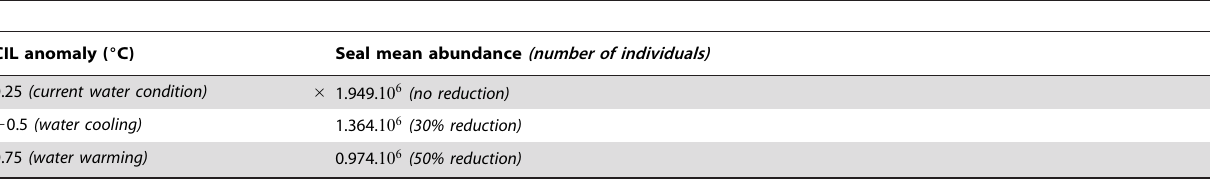
Table 6. Projection scenarios considered in the analysis. CIL= cold intermediate layer. In each case, three fishing strategies are considered (from current practice to moratorium).